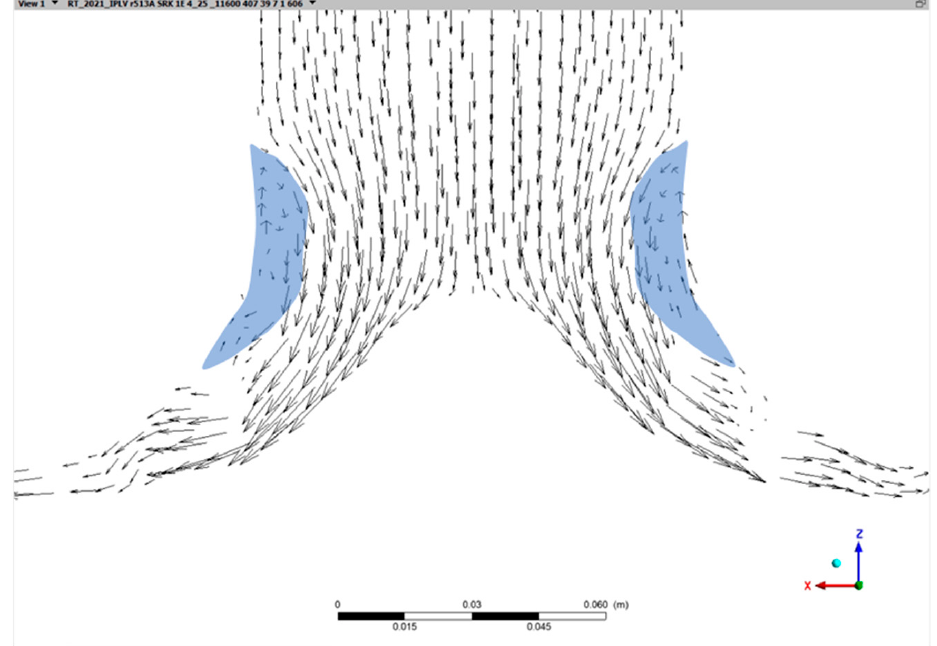
Figure 23. Compressor impeller velocity vector diagram of R-1234yf refrigerants under 25% load.